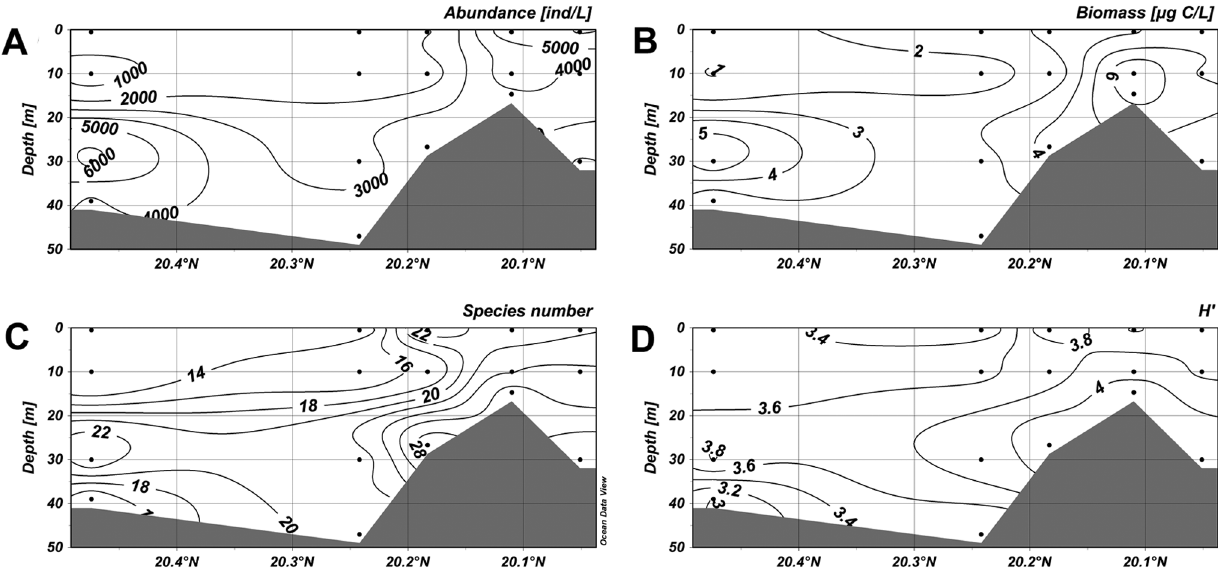
Figure 7. Vertical distribution of planktonic ciliates in the section 4–19. (A) Vertical distribution of abundance. (B) Vertical distribution of biomass. (C) Vertical distribution of species number. (D) Vertical distribution of diversity. The horizontal axis and vertical axis expressed the gradients in latitude and water depth, respectively. (TIFF).